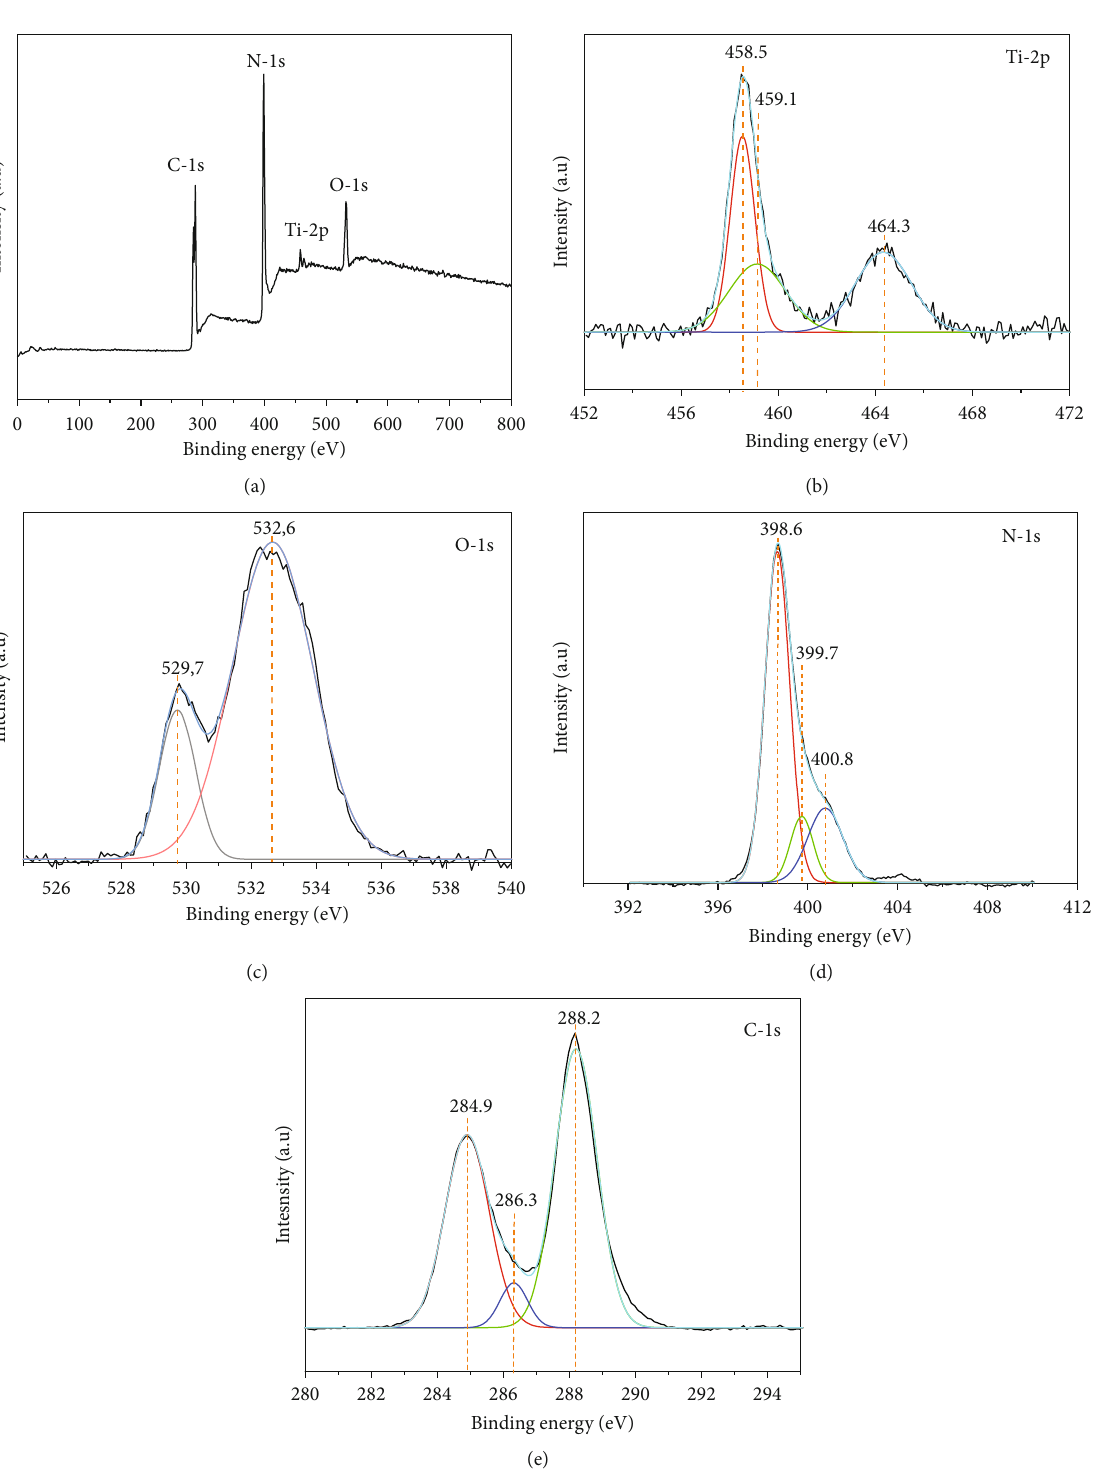
Figure 5: X-ray photoelectron spectra of 5TiCN: (a) survey spectra; (b) high-resolution spectra of Ti2p, (c) high-resolution spectra of O1s; (d) high-resolution spectra of N1s; (e) high-resolution spectra of